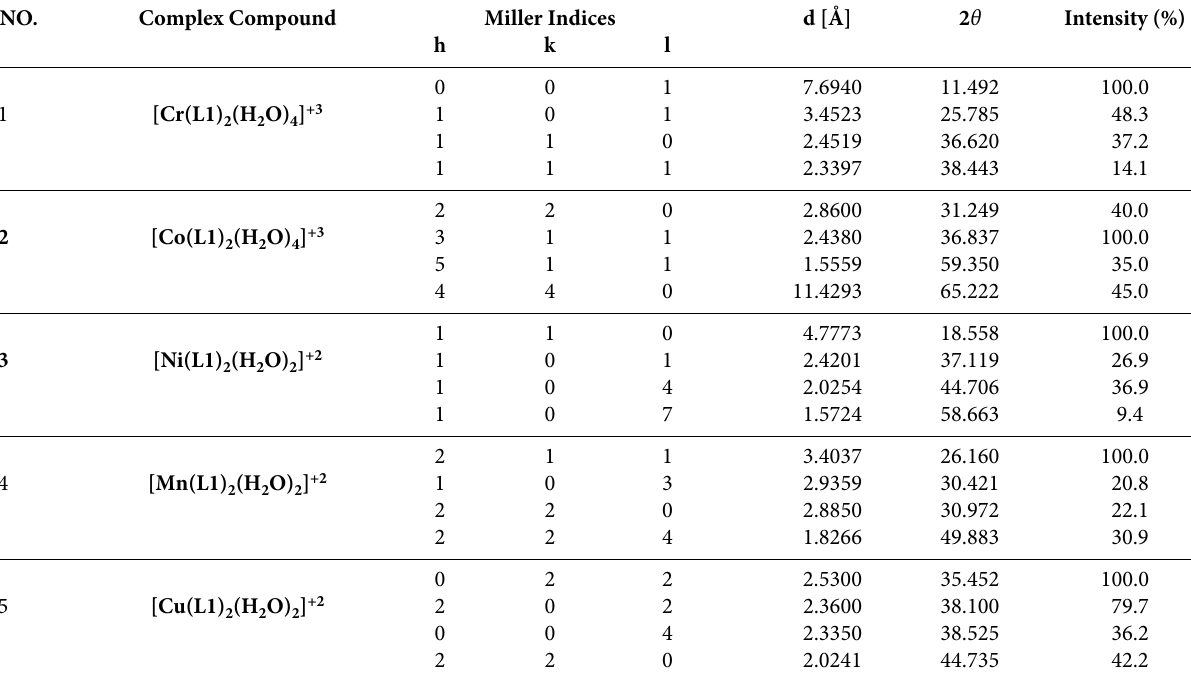
Table 3. Crystal lattice Data and Summary of Data Collection and Refinement for complexes 4-8 S.NO.